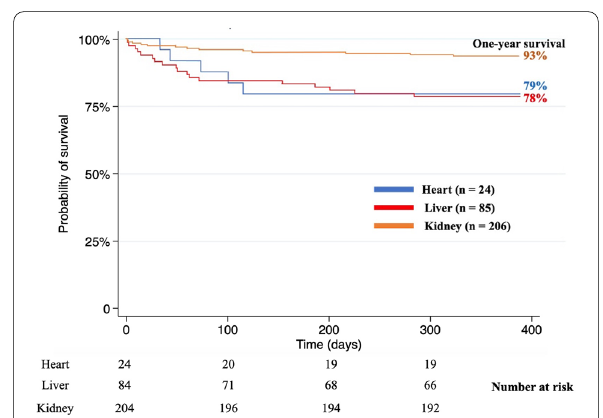
HR: hazard ratio; OHCA: out-of-hospital cardiac